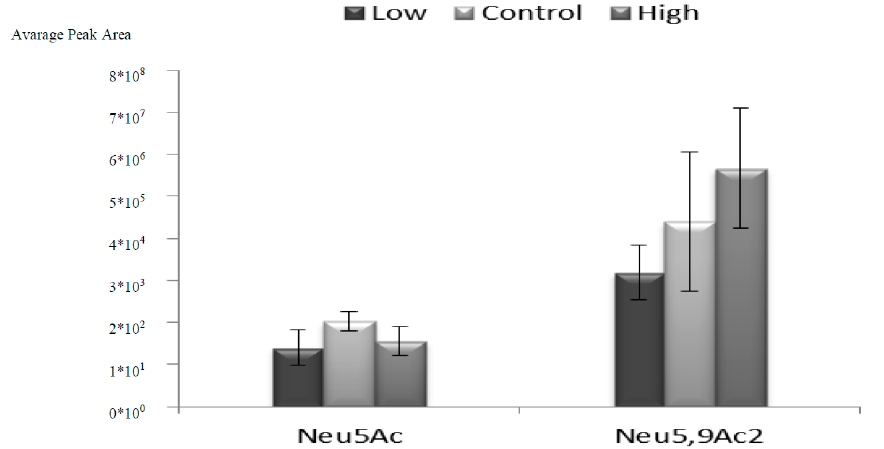
Figure 3. Proportional amounts of free Sia (Neu5Ac and